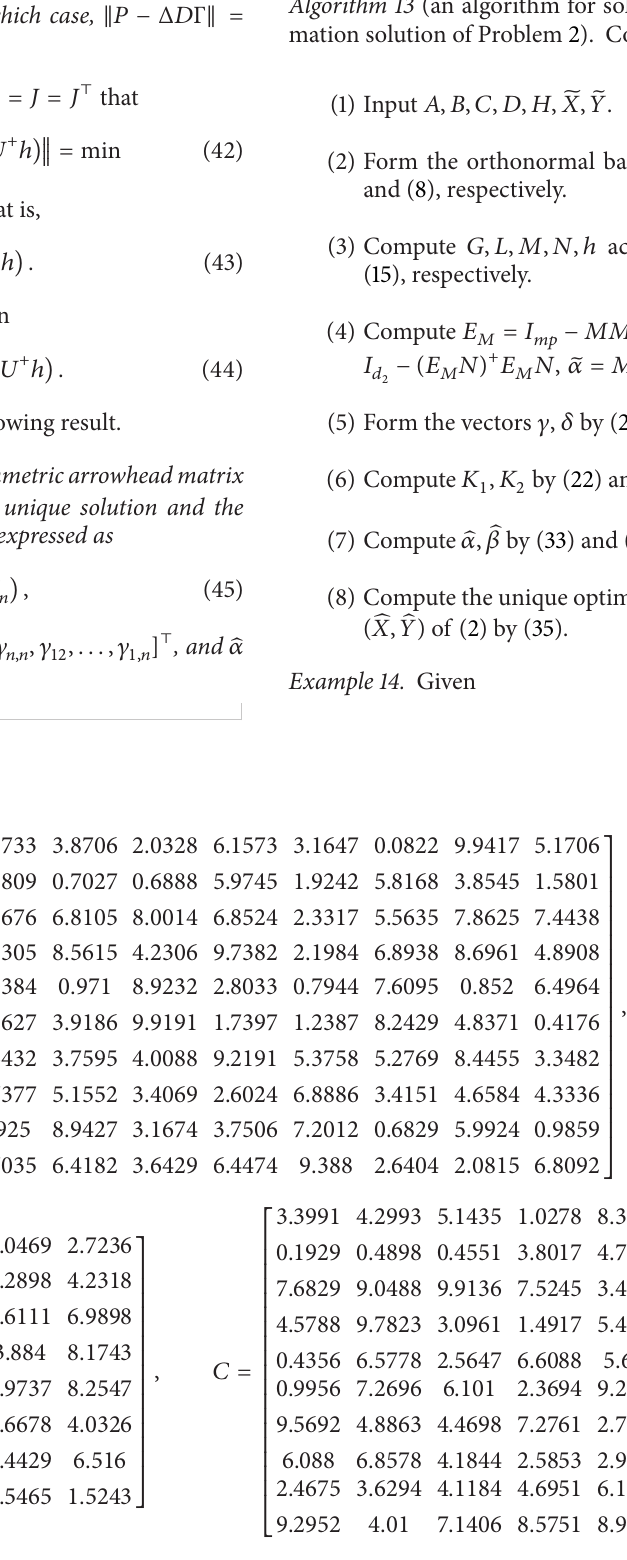
Algorithm 13 (an algorithm for solving the optimal